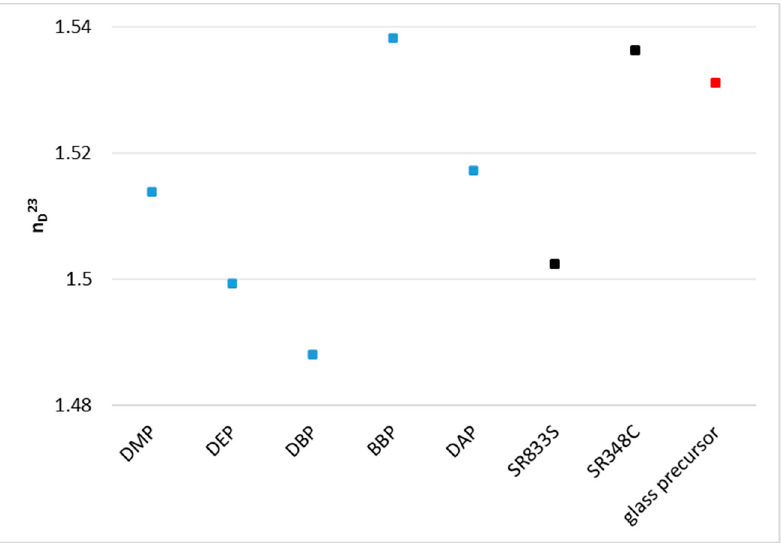
Figure 8. Comparison of the refractive indices of pure substances with the target value of the glass filler (value taken from literature [18]).